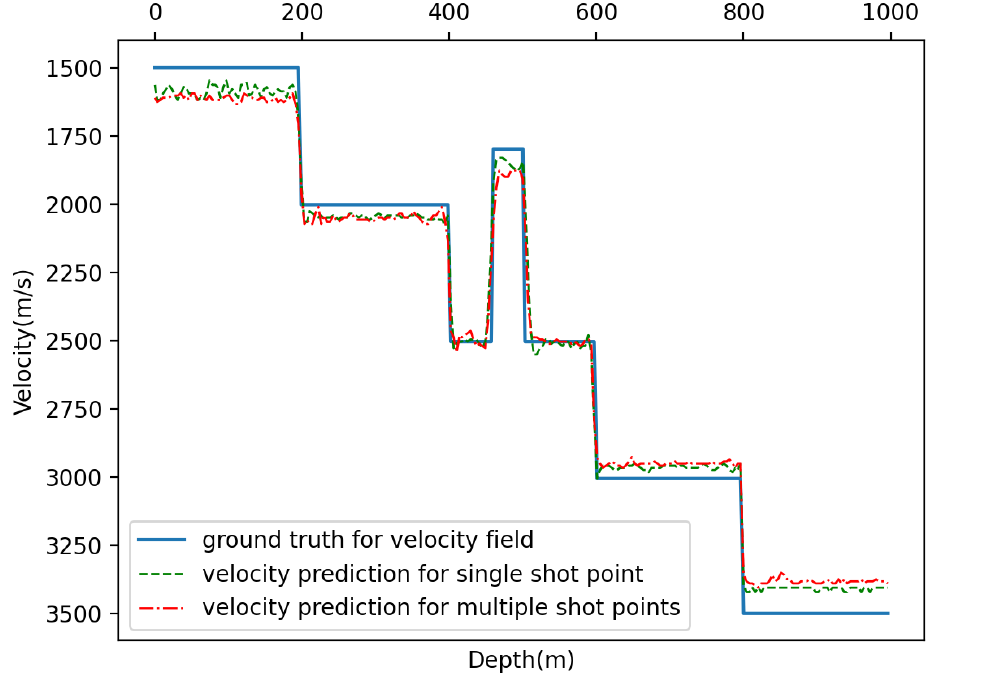
Figure 10. Vertical velocity profiles of velocity field with one anomaly and no